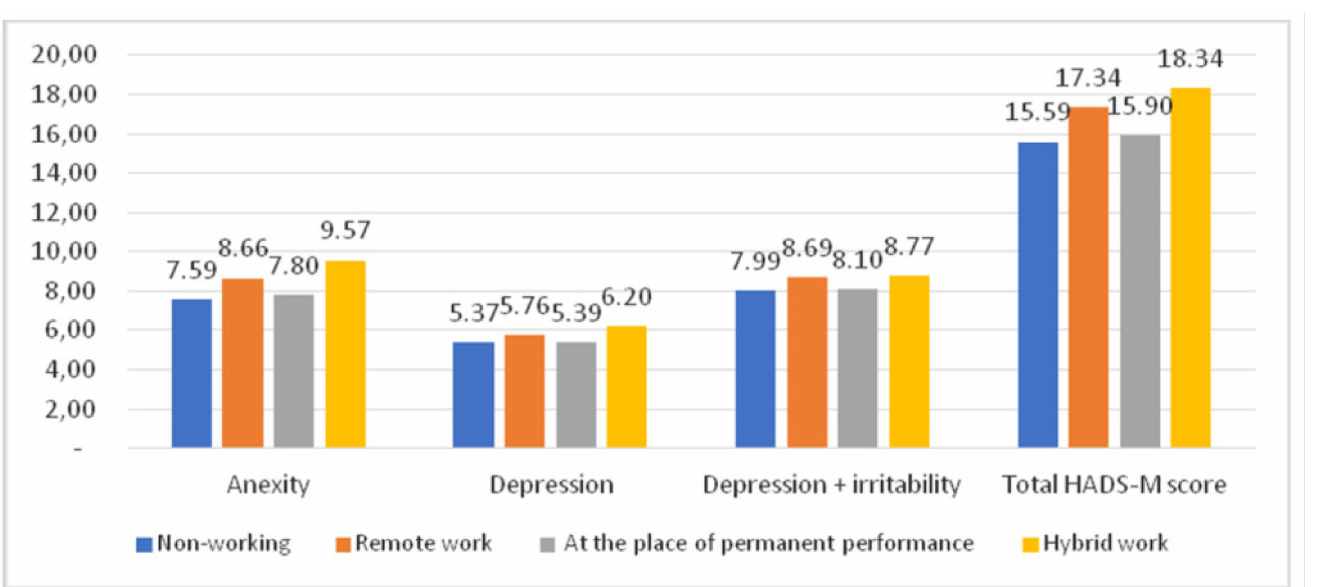
Figure 5. Place of work and the HADS-M score.